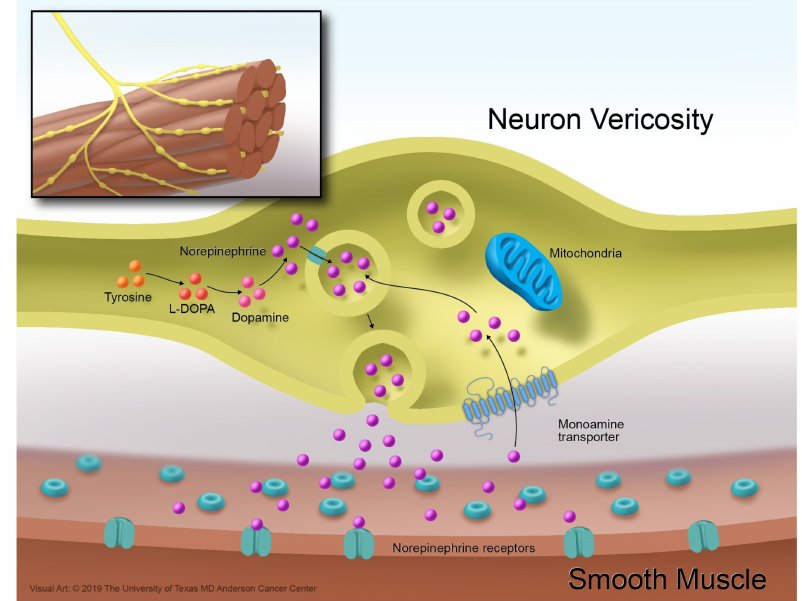
Figure 3. Norepinephrine reuptake